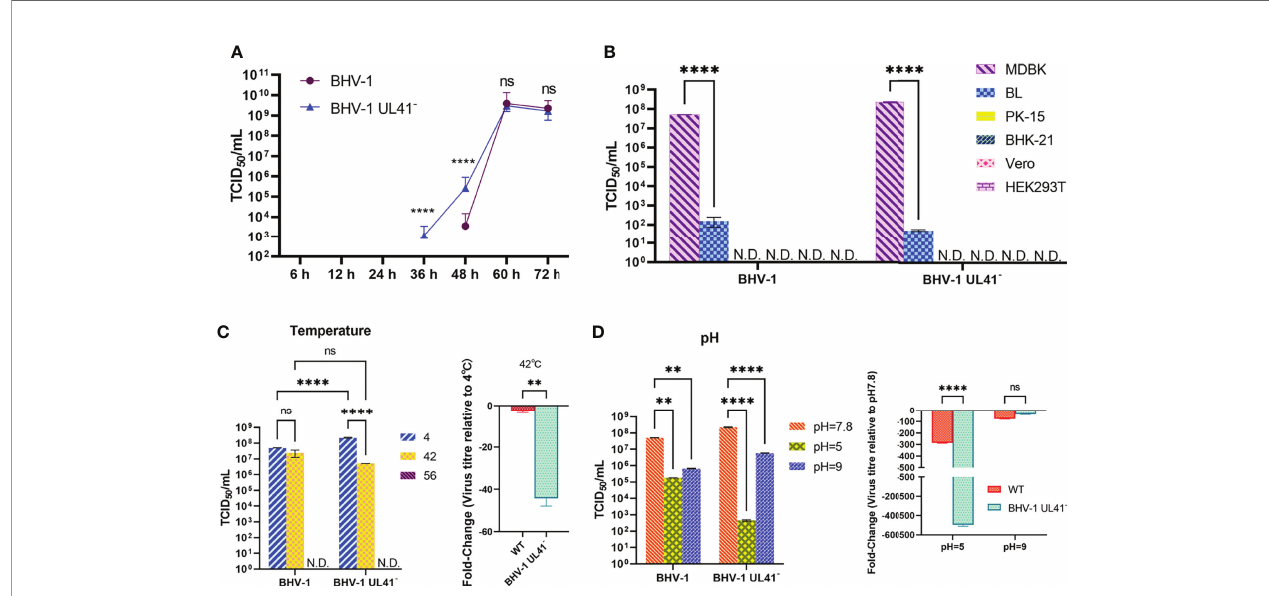
FIGURE 4 | Evaluation of viral replication and environmental stability. (A) One-step growth curve of the BHV-1 UL41 − and WT viruses. MDBK cells were infected with viruses at an MOI of 0.01, and the viruses were collected after inoculation for 6, 12, 24, 36, 48, 60, and 72 h. The viral titers were recorded as TCID 50 /ml values. The blue triangle indicates the growth curve of BHV-1 UL41 − , and the purple circle indicates the growth curve of the WT strain. (B) Cell tropism analysis of BHV-1 UL41 − and the WT strain. MDBK, BL, PK-15, BHK-21, Vero, and HEK293T cells were used to detect the cell tropism of the viruses. N.D. stands for not detected. (C) Temperature sensitivity analysis of BHV-1 UL41 − and the WT strain. The number 4 indicates that the viruses were collected and stored at 4°C for temperature stability detection. The number 42 indicates that the viruses were kept at 42°C for 30 min and cold at 4°C. The number 56 indicates that the viruses were kept at 56°C for 30 min and cold at 4°C. The data are plotted as the fold change over 4°C. N.D. stands for not detected. (D) pH sensitivity analysis of BHV-1 UL41 − and the parent strain. pH 7.8 indicates the pH of the initial viral solution; pH 5 indicated that the viruses recovered to pH 7.8 from pH 5; pH 9 indicates that the viruses recovered to pH 7.8 from pH 9; and the data are plotted as the fold change over pH 7.8. The viral titers were detected in three independent experiments and calculated as the mean ± SD. **** for p < 0.0001, ** for p < 0.01, and ns for no signi fi